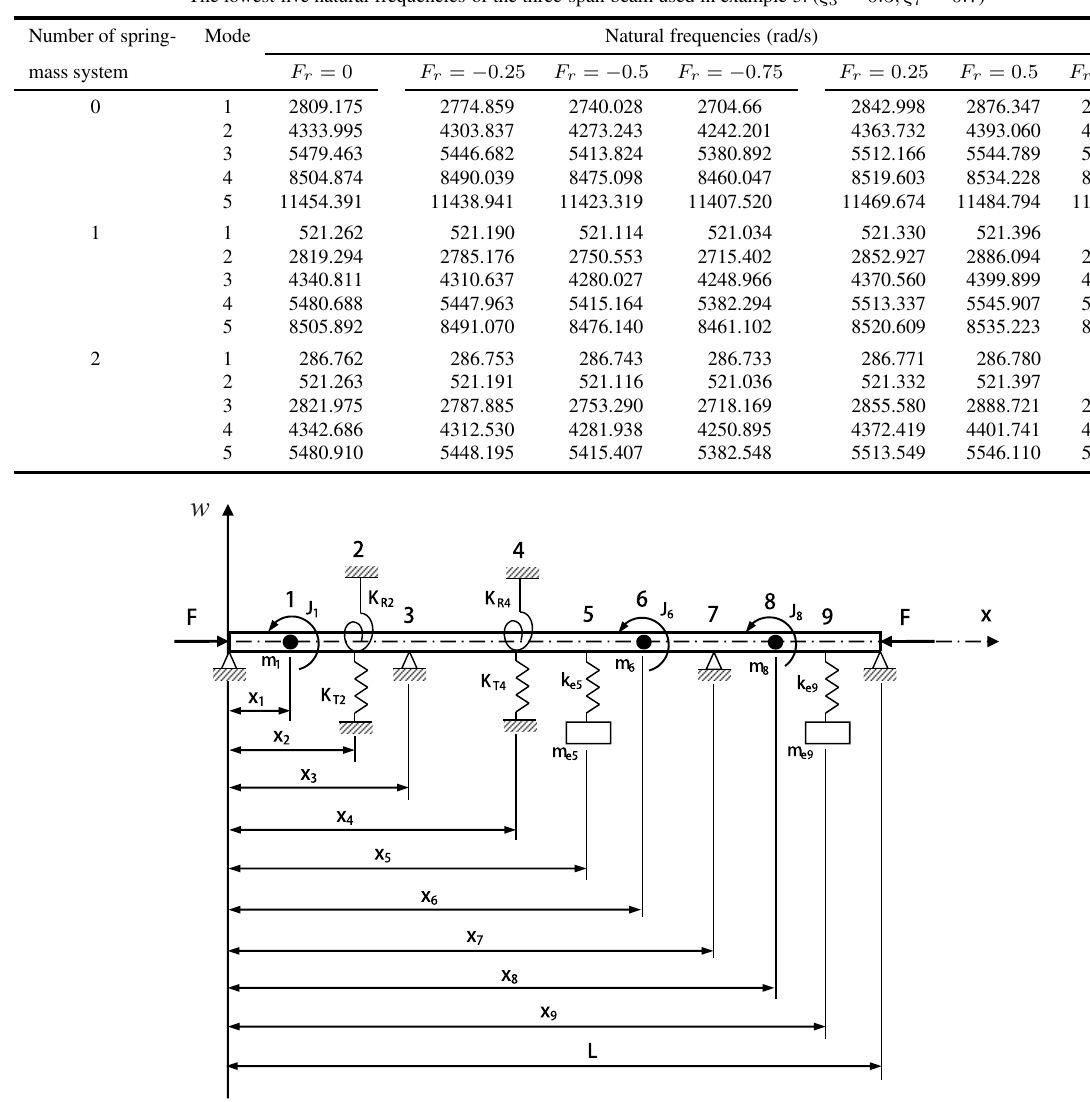
Fig. 1. A uniform beam supported by pins, carrying various concentrated elements and subjected to axial load.